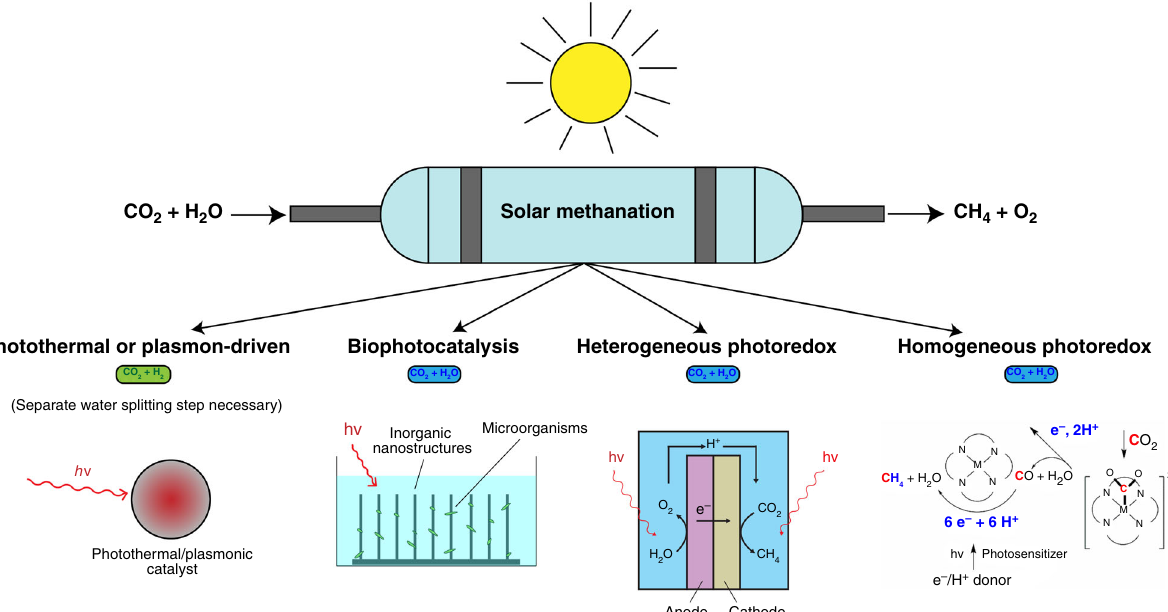
Fig. 1 Schematic depiction of the solar methanation process and the various methods covered in this review paper. This includes the four main catalysis methods that are discussed: Photothermal or plasmon-driven, biophotocatalysis (hybrid bio-inorganic), heterogeneous photoredox and homogeneous